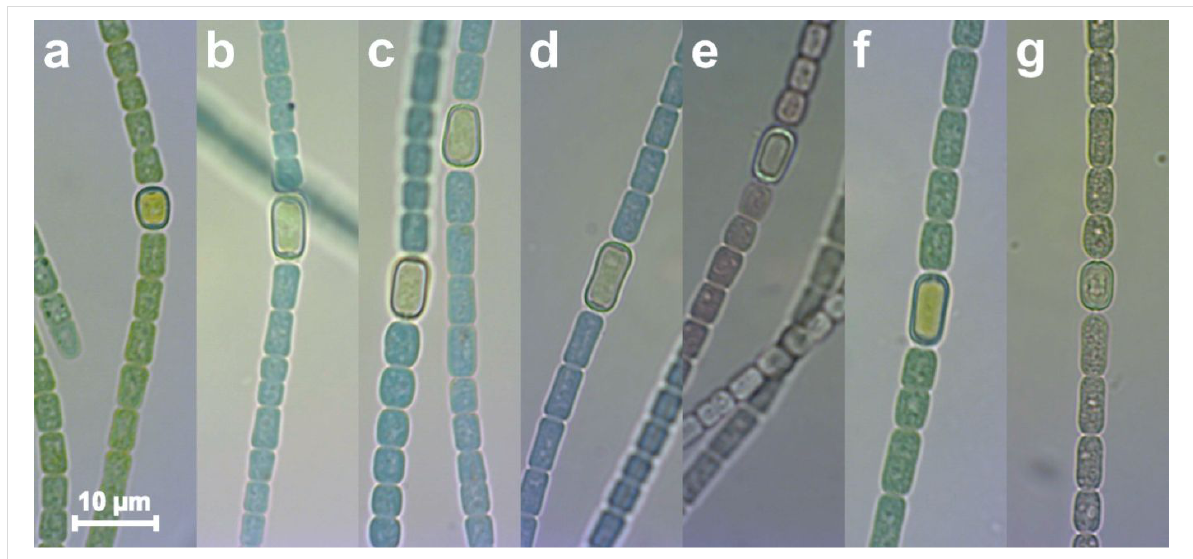
Figure 1: Optical microscopy of Anabaena cylindrica cultures developing untreated as reference (a, f) and growing incubated with an overall concen- tration of 0.8 mM Au 3+ (b–e). Images were taken before incubation (a), after six hours (b), eleven hours (c) and 24 hours (d) of gold salt incubation. After 190 hours (eight days) (e) no vital cells were found in the incubated culture anymore, while the reference at this time seems to be unaltered (f). Image (g) shows degraded Anabaena cylindrica after diluted HCl was added for comparison.